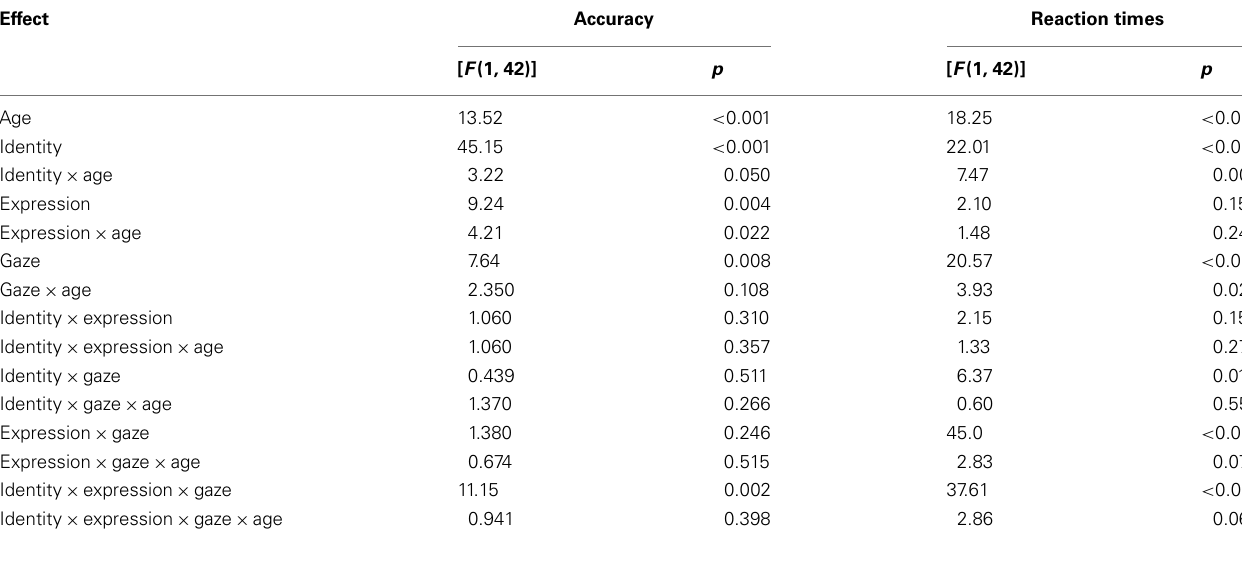
Table 3 | Experiment 2: main effects and interactions for the experimental factors identity × expression × gaze × age